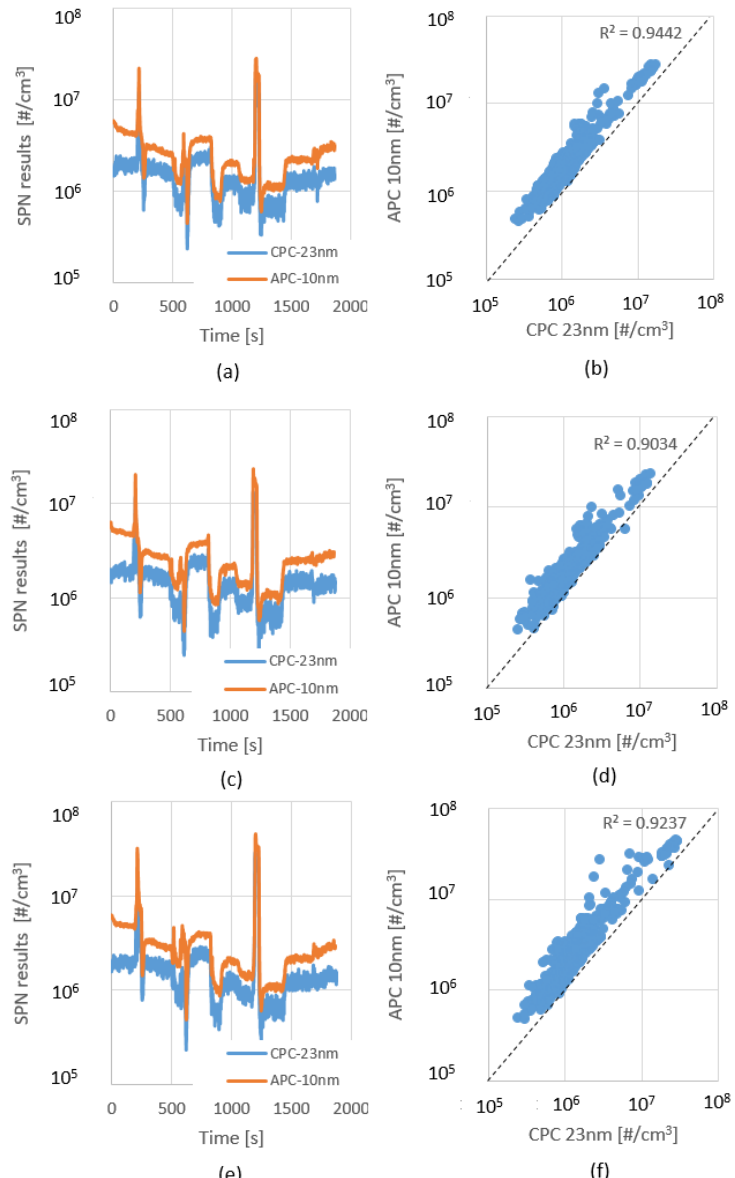
Figure 7. Transient particle concentration over 1st ( a ); 2nd ( c ); 3rd ( e ) WHSC cycle; Proportion of variance between <10 nm and <23 nm results over 1st ( b ); 2nd ( d ); 3rd ( f ) WHSC cycle. APC = AVL Particle Counter; CPC = Condensation Particle Counter; SPN = Solid Particle Number.